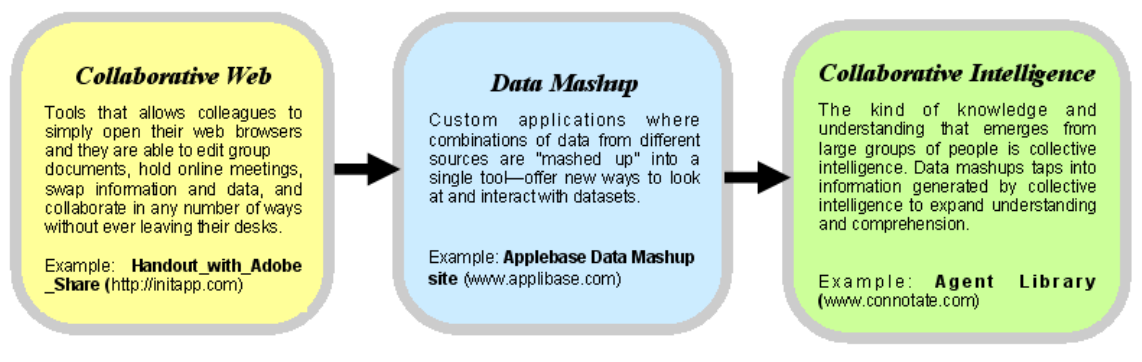
Figure 1. Increasing Levels of Mashup Semantic